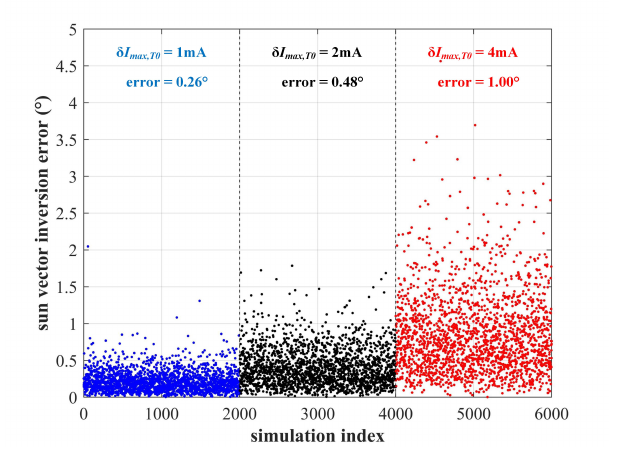
Figure 8. The sun vector inversion accuracy considering reference current error of various magnitudes.